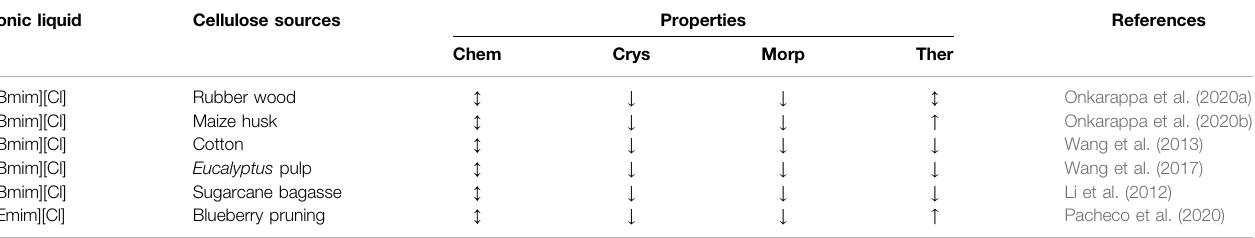
TABLE 5 | Properties of nanocellulose extracted by chloride anion-based ionic liquids. Ionic